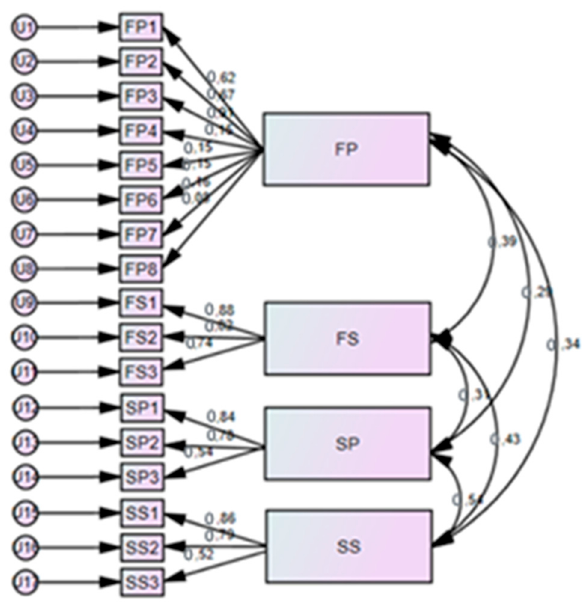
Figure 1. Path Figure 1. Path diagram. Table 5. Correlation and covariance.